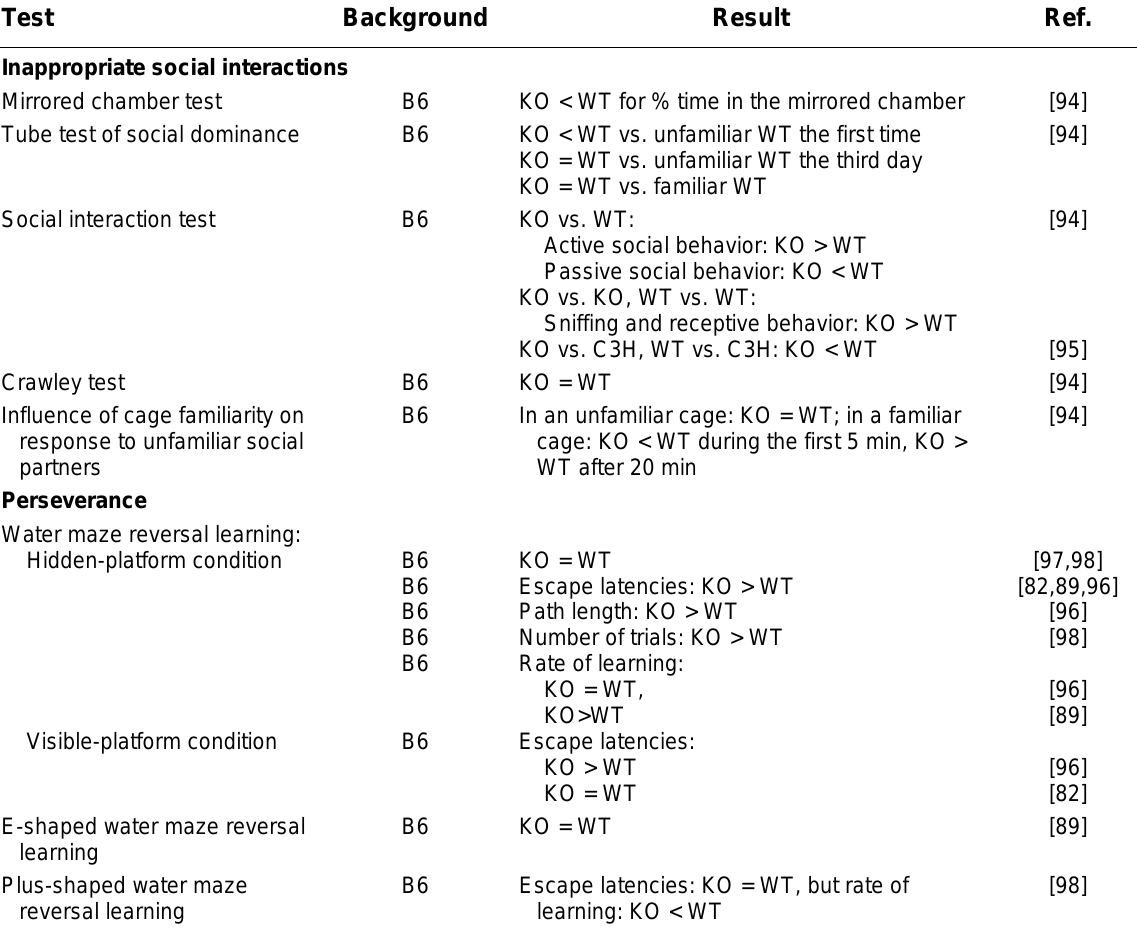
Phenotypical Checkup of Fmr1 KO Mice: Behaviors Relevant to Core Symptoms of Autism Test